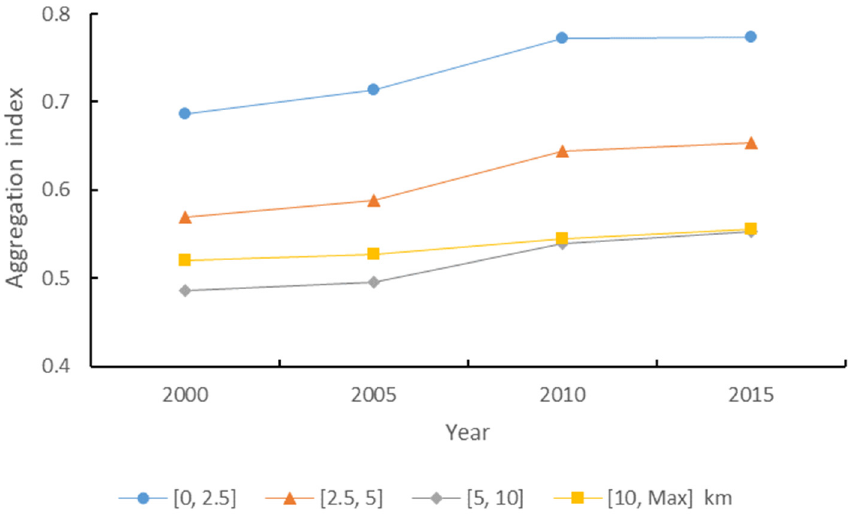
Figure 6. Changes in the balance of land use structure between buffer zones in Dalian.